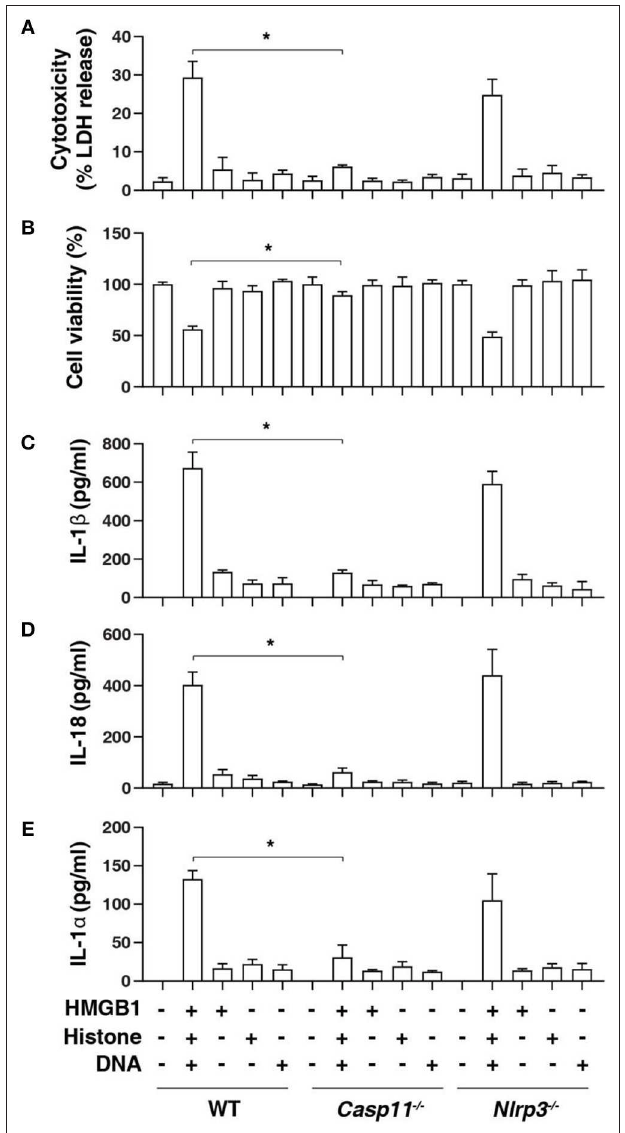
FIGURE 1 | Caspase-11 is required for nuclear DAMP complex-induced pyroptosis. Indicated LPS-primed BMDMs were treated with HMGB1 (500ng/mL), histone (500ng/mL), and genomic DNA (500ng/mL) for 16h, then cytotoxicity (A) , cell viability (B) , IL-1 β release (C) , IL-18 release (D) , and IL-1 α release (E) were assayed. n = 3, data expressed as means ± SD of three independent experiments, * P < 0.05, t